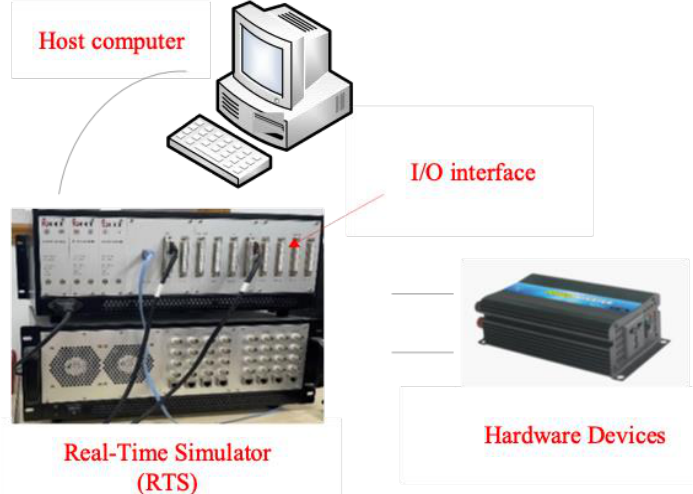
Figure 1. SPACER real time simulator.